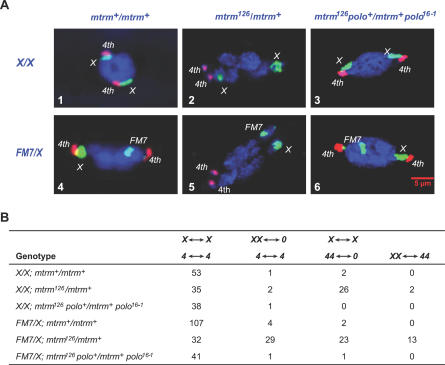
Heterozygosity for mtrm126 Impairs the Proper Co-Orientation of Achiasmate Centromeres during Prometaphase(A) FISH analysis using probes homologous to the X and 4
th chromosomal heterochromatin [29] were used to assay centromere co-orientation during meiotic prometaphase. In mtrm+/ mtrm+ oocytes carrying either chiasmate X chromosomes (XX females) or achiasmate X chromosomes (FM7/X females), the centromeres of both the X and the 4
th are virtually always oriented toward opposite poles (see panels 1 and 4 and (B)). However, in mtrm/+ heterozygotes, the centromeres of achiasmate bivalents are often oriented towards the same pole (see panels 2 and 5 and (B)). In double heterozygotes for both mtrm and polo, these defects in achiasmate chromosome centromere co-orientation are greatly suppressed (panels 3 and 6).(B) Quantitative summary of centromere co-orientation patterns for the various genotypes studied. Although heterozygosity for mtrm126 has a dramatic effect on 4
th chromosome centromere malorientation in both XX and FM7/X females, there is little effect on X chromosome segregation in XX oocytes when compared with the dramatic effect observed in FM7/X females. This is to be expected based on the genetic studies of Harris et al. [9], who observed that only achiasmate bivalents nondisjoin in mtrm/+ females.